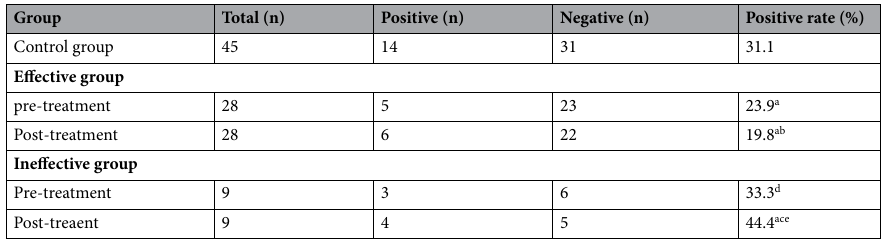
Table 6. Effect of immunosuppressants on P-gp expression in UC. a P < 0.05 versus normal control. b P > 0.05 versus pre-treatment. c P < 0.05 versus pre-treatment. d P < 0.05 versus effective group pre-treatment. e P < 0.05 versus effective group